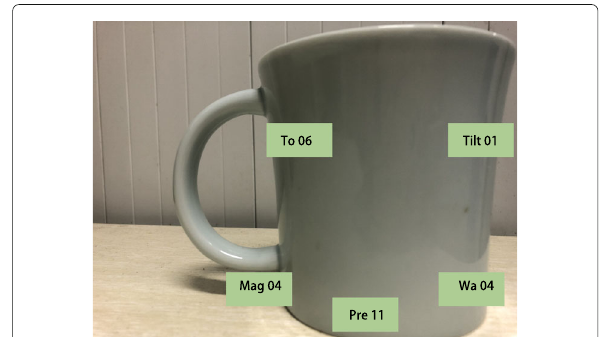
Fig. 4 A cup model of multi-modeling sensors